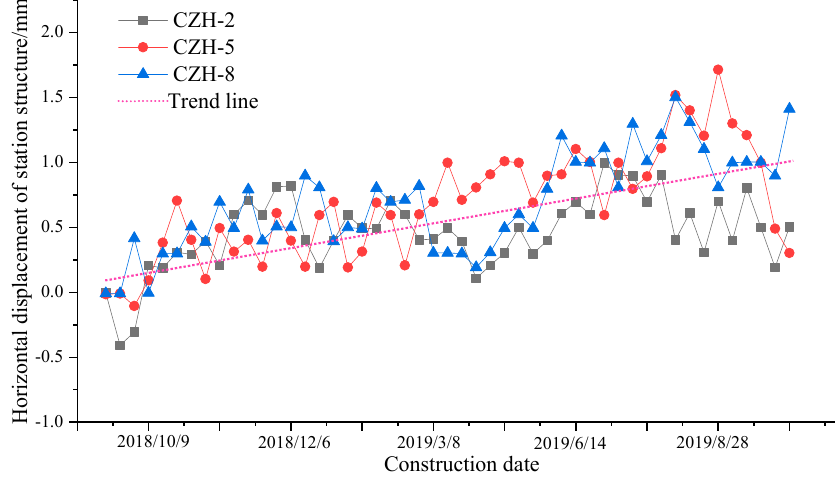
Figure 10. Time − history curve of the horizontal displacement of the station structure.